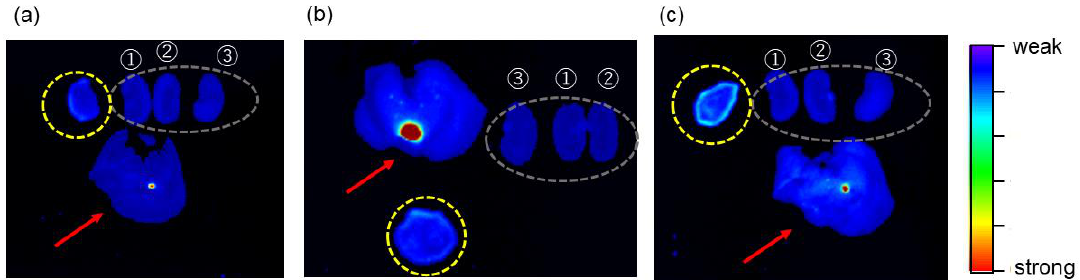
Figure 5. Fluorescence imaging of tumors (broken yellow circles), kidneys (broken gray ovals), and livers (red arrows) was visualized using TFMAQ-diEg4 emission. The numbers 1 to 3 along the kidneys indicate a kidney cut in half (1 and 2) or a whole kidney (3). Representative images shown are of groups 1 ( a ), 2 ( b ), and 3 ( c ).